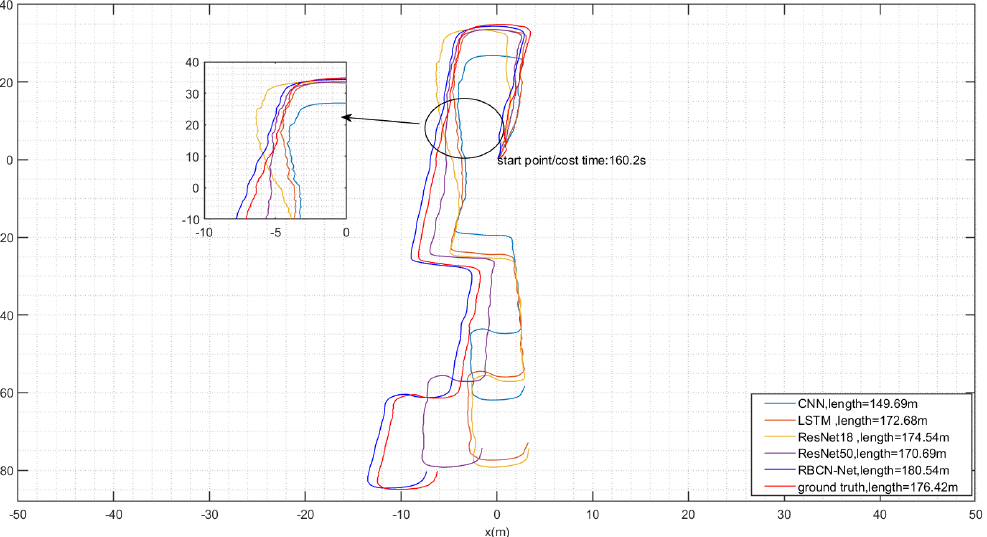
Figure 9. Comparison of five competing networks trajectory and the real trajectory.